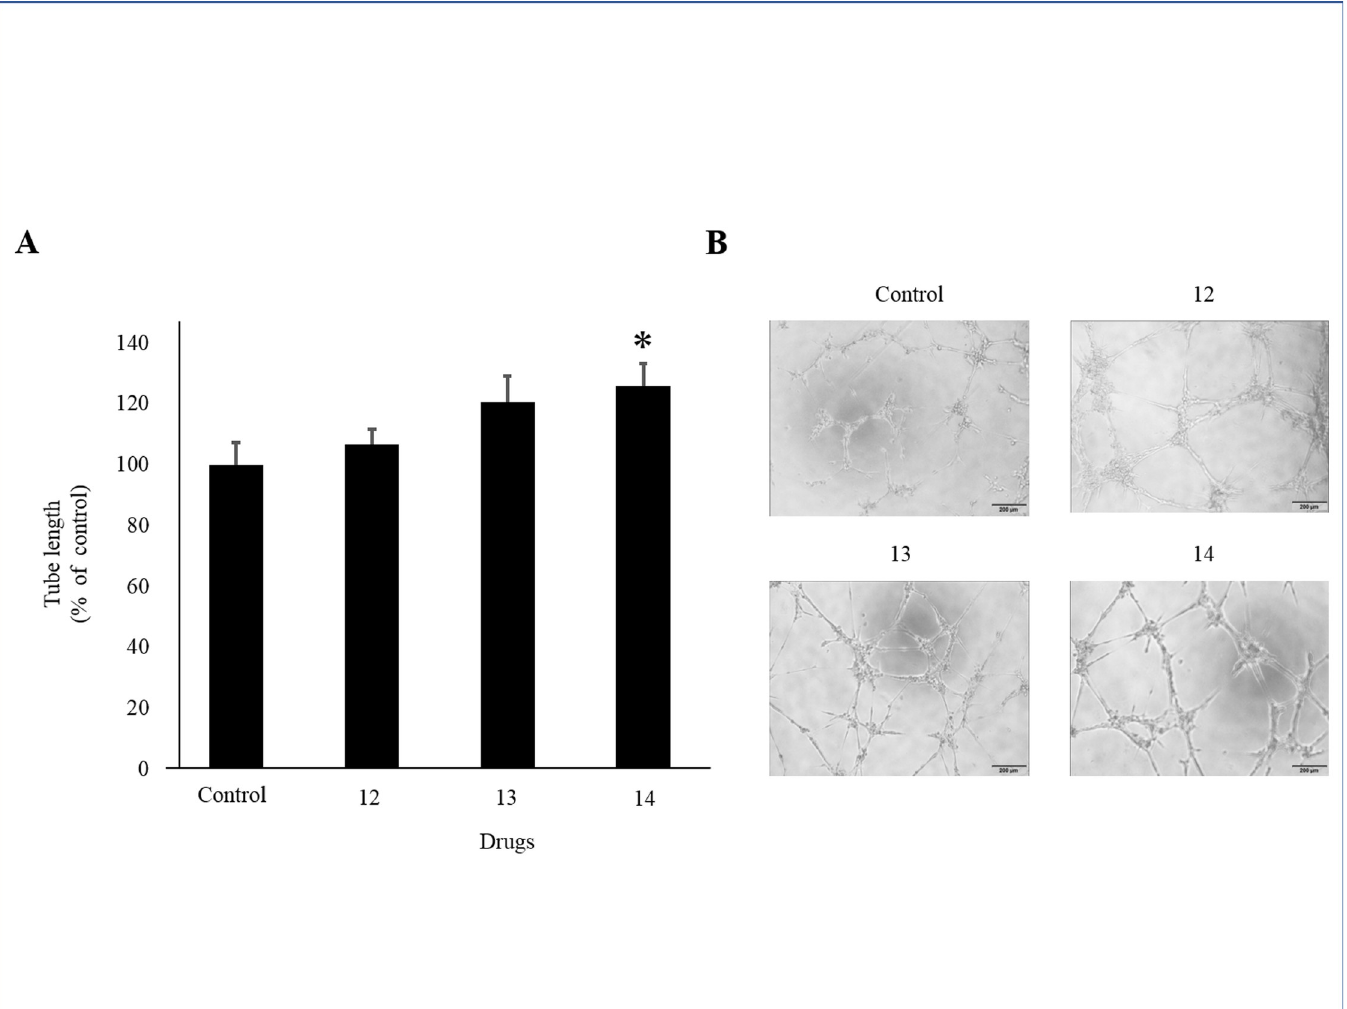
Fig 3. Effect of selected Kampo drugs on microvascular tube formation in HUVECs. A: Quantification of total tube length. B: Representative images. � indicates P < 0.05. 12: Shoseiryuto; 13: Shofusan; 14: Tokishakuyakusan. HUVECs, human umbilical vein endothelial cells.